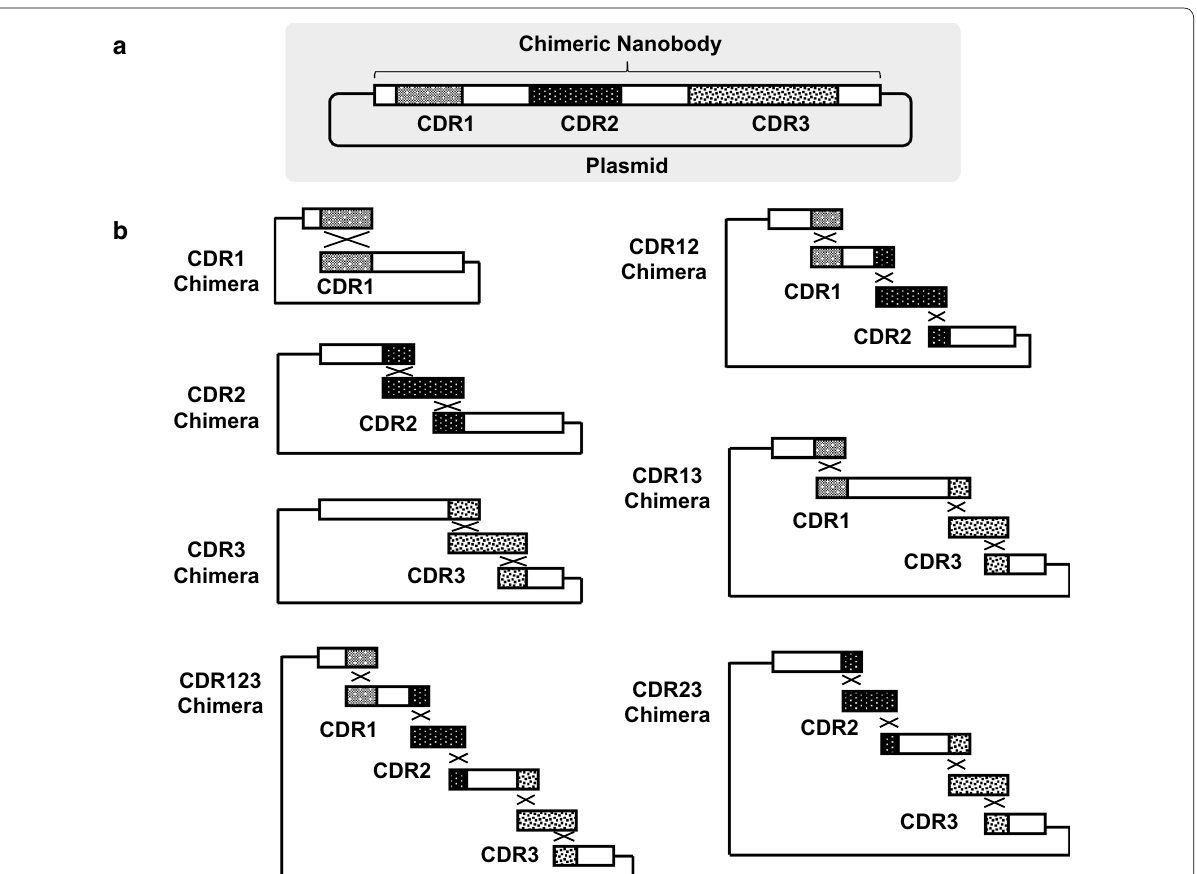
Fig. 2 Overview of plasmid construction schemes for production of chimeric nanobodies. a Overview of the composition of chimeric nanobodies. Nanobodies with CDR1, 2, and 3 were inserted into single plasmids. b Scheme for preparing each chimera. Cross: positions of homologous